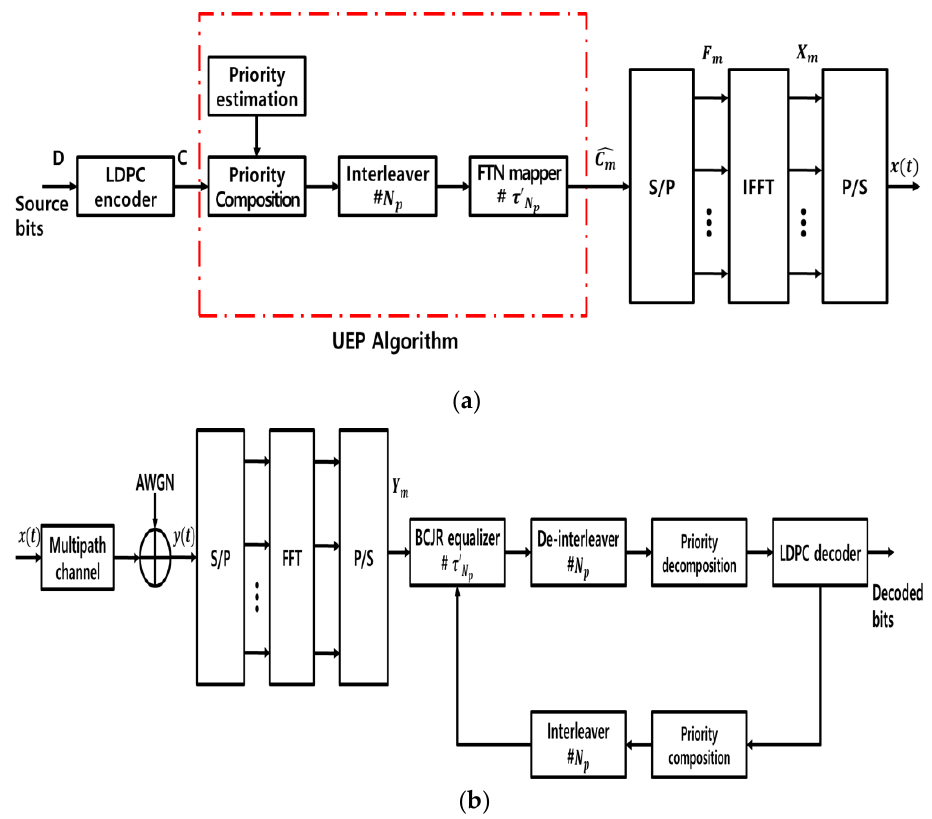
Figure 11. The transceiver structure of OFDM-FTN model based on the UEP algorithm: ( a ) Transmitter; ( b ) receiver.